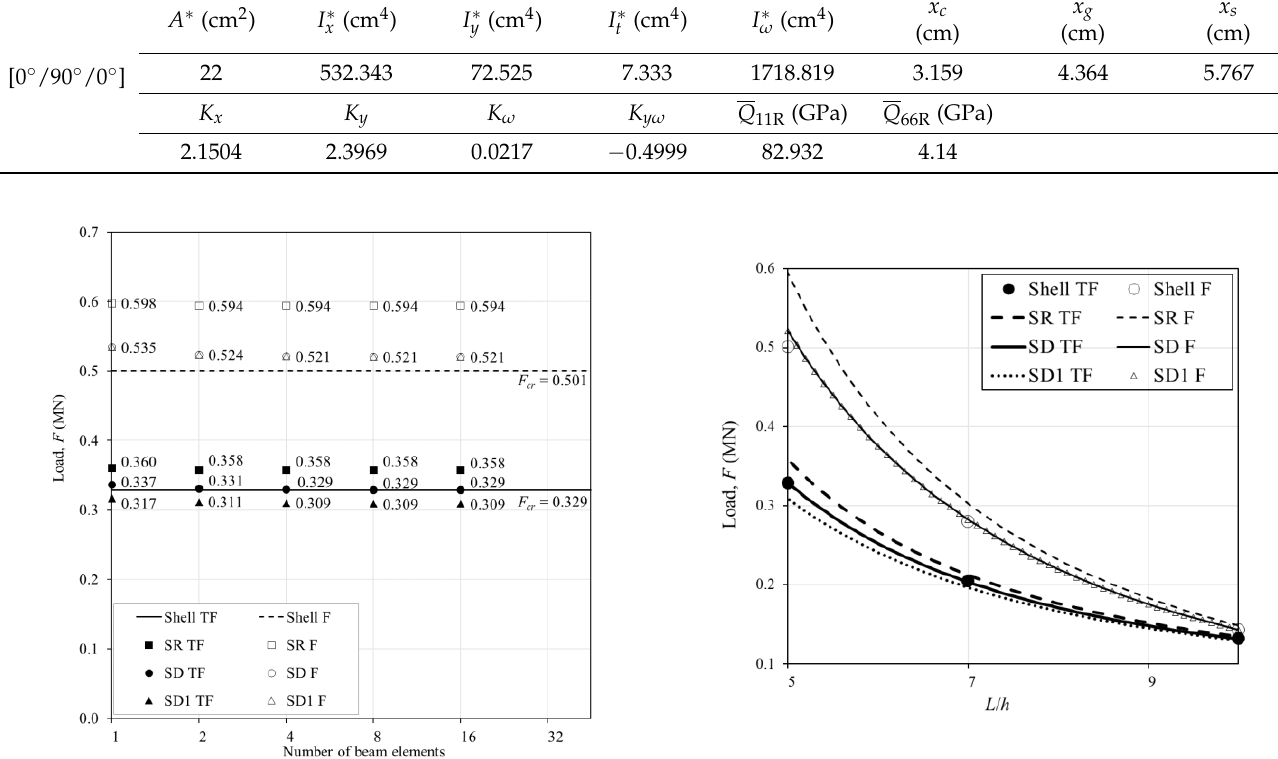
Figure 5. ( a ) Buckling load convergence for L = 50 cm and ( b ) buckling load vs. column length.